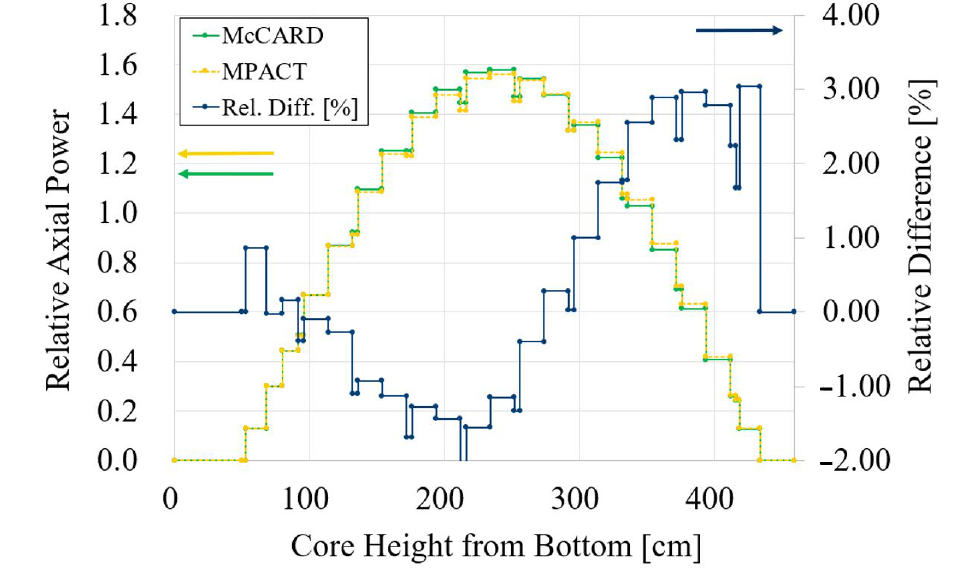
Figure 22. Axial power and relative difference from McCARD for CZ1 case.